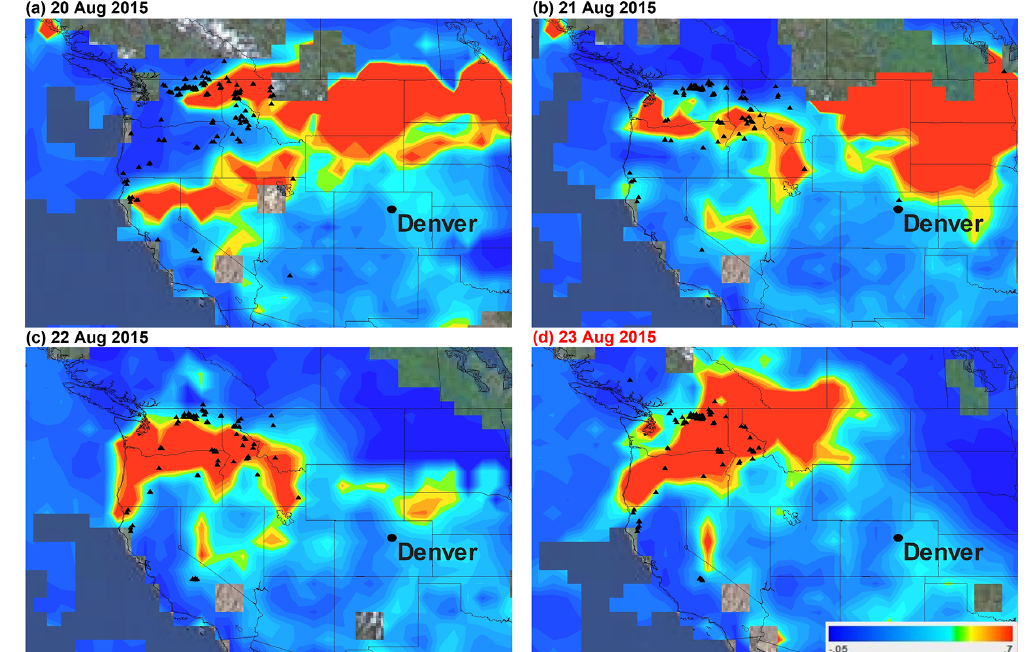
Figure 5. Same as Fig. 4 but for the second major haze event between 20 and 23 August 2015. The haziest day from the CDPHE data is labeled in red (i.e., event